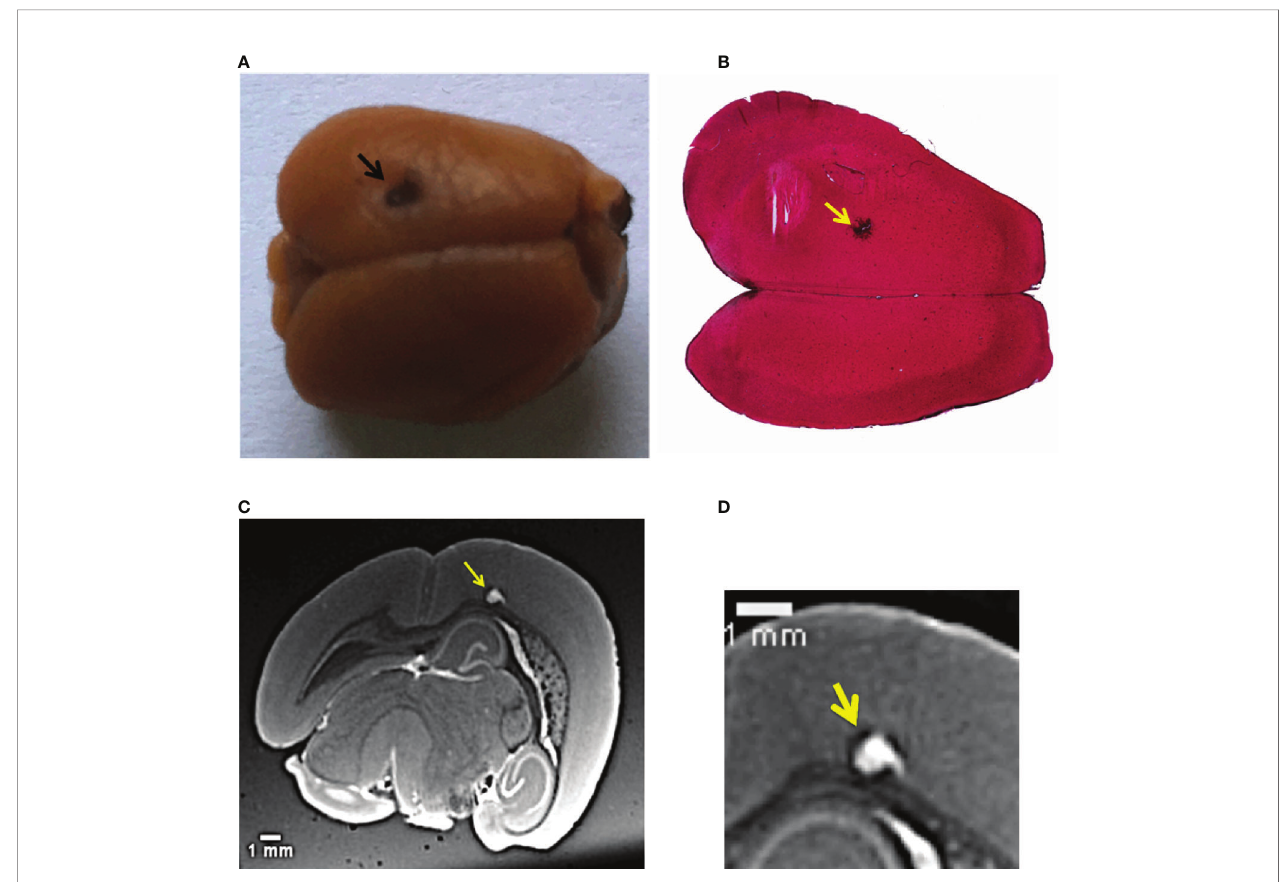
FIGURE 1 | Multi-modal images of the melanoma primary tumor. (A) Image of the mouse brain showing the primary tumor. The black dot on the left upper hemisphere, indicated by the black arrow, represents the injection point of the tumor cells. (B) Histology image of the brain with a ×2.5 objective. The brain slice was stained with hematoxylin/eosin. The yellow arrow indicates melanin aggregation typical of melanomas. (C) Image selected from the T 1 -MRI sequence. The yellow arrow points the main melanoma lesion developed in the mouse brain cortex in correspondence of the point of the injection of tumor cells. (D) Close-up of the MRI slice that crosses the